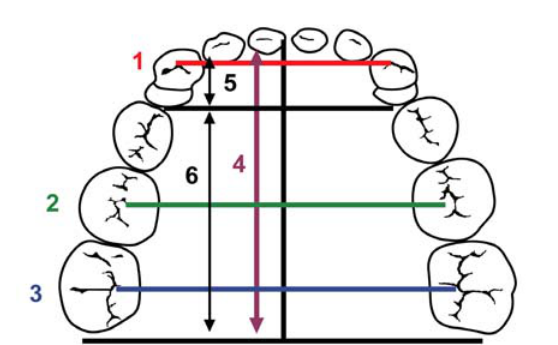
Figure 1- Maxillary and mandibular dental